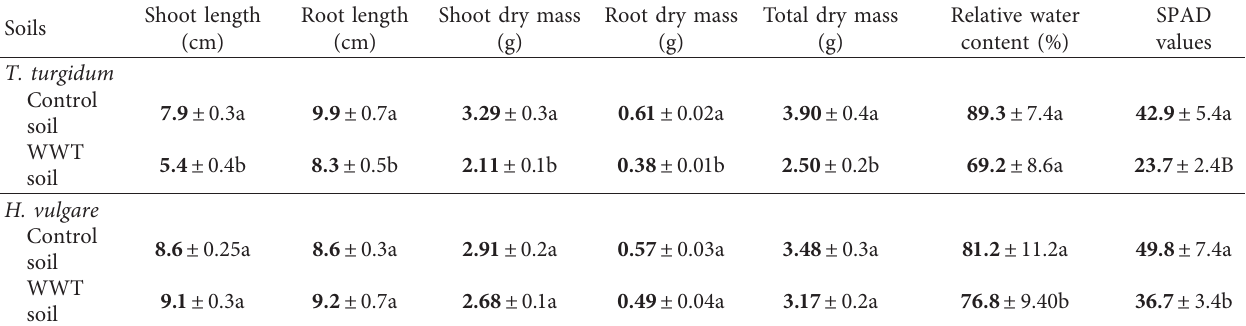
Table 3: Element concentrations (mg. kg − 1 DW) in shoot and root of durum wheat and barley on control soil and soil irrigated with wastewater from the pumping water treatment station of CRDA